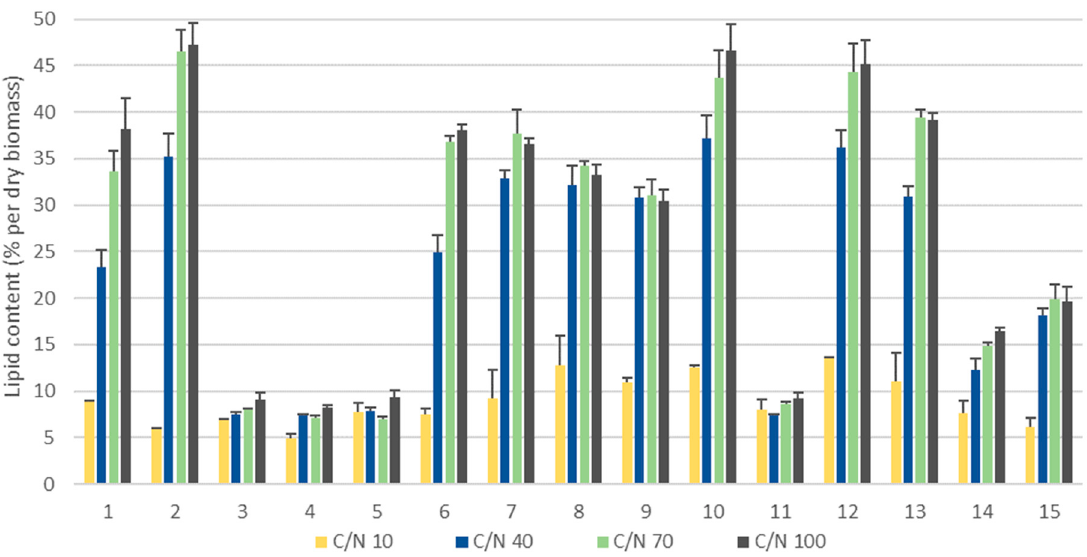
Figure 1. Lipid content (% w/w ) in yeast grown in the media with low and high C/N ratios. Yeast strain numbers are described in Table 1.